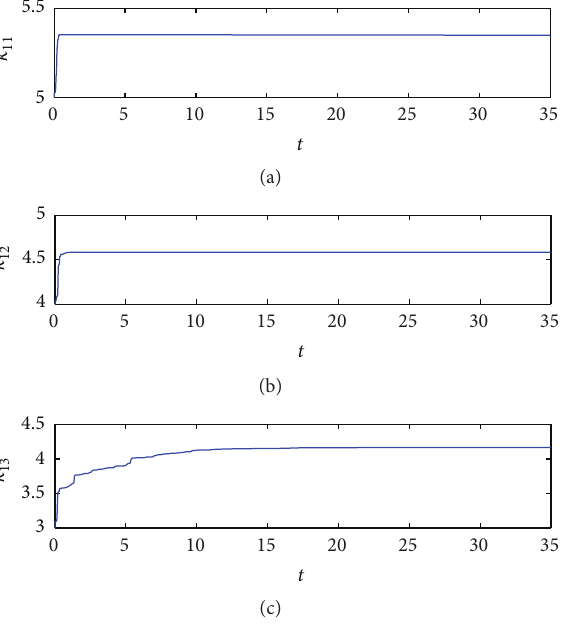
Figure 7: The trajectories of the adaptive laws 𝛼 in Example 1.